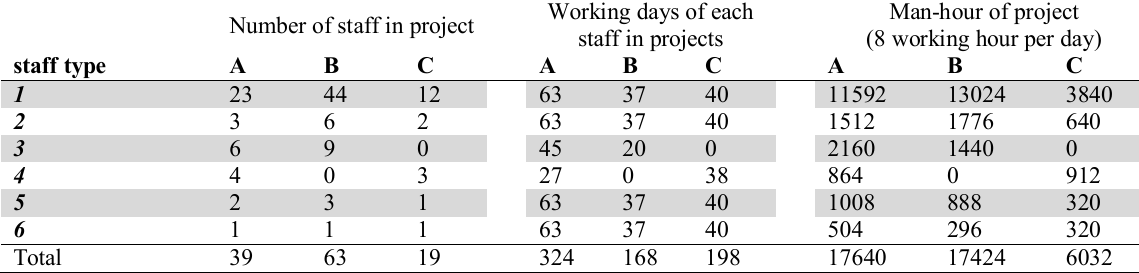
Human resources utilized in three projects A, B and C Working days of each Number of staff in project